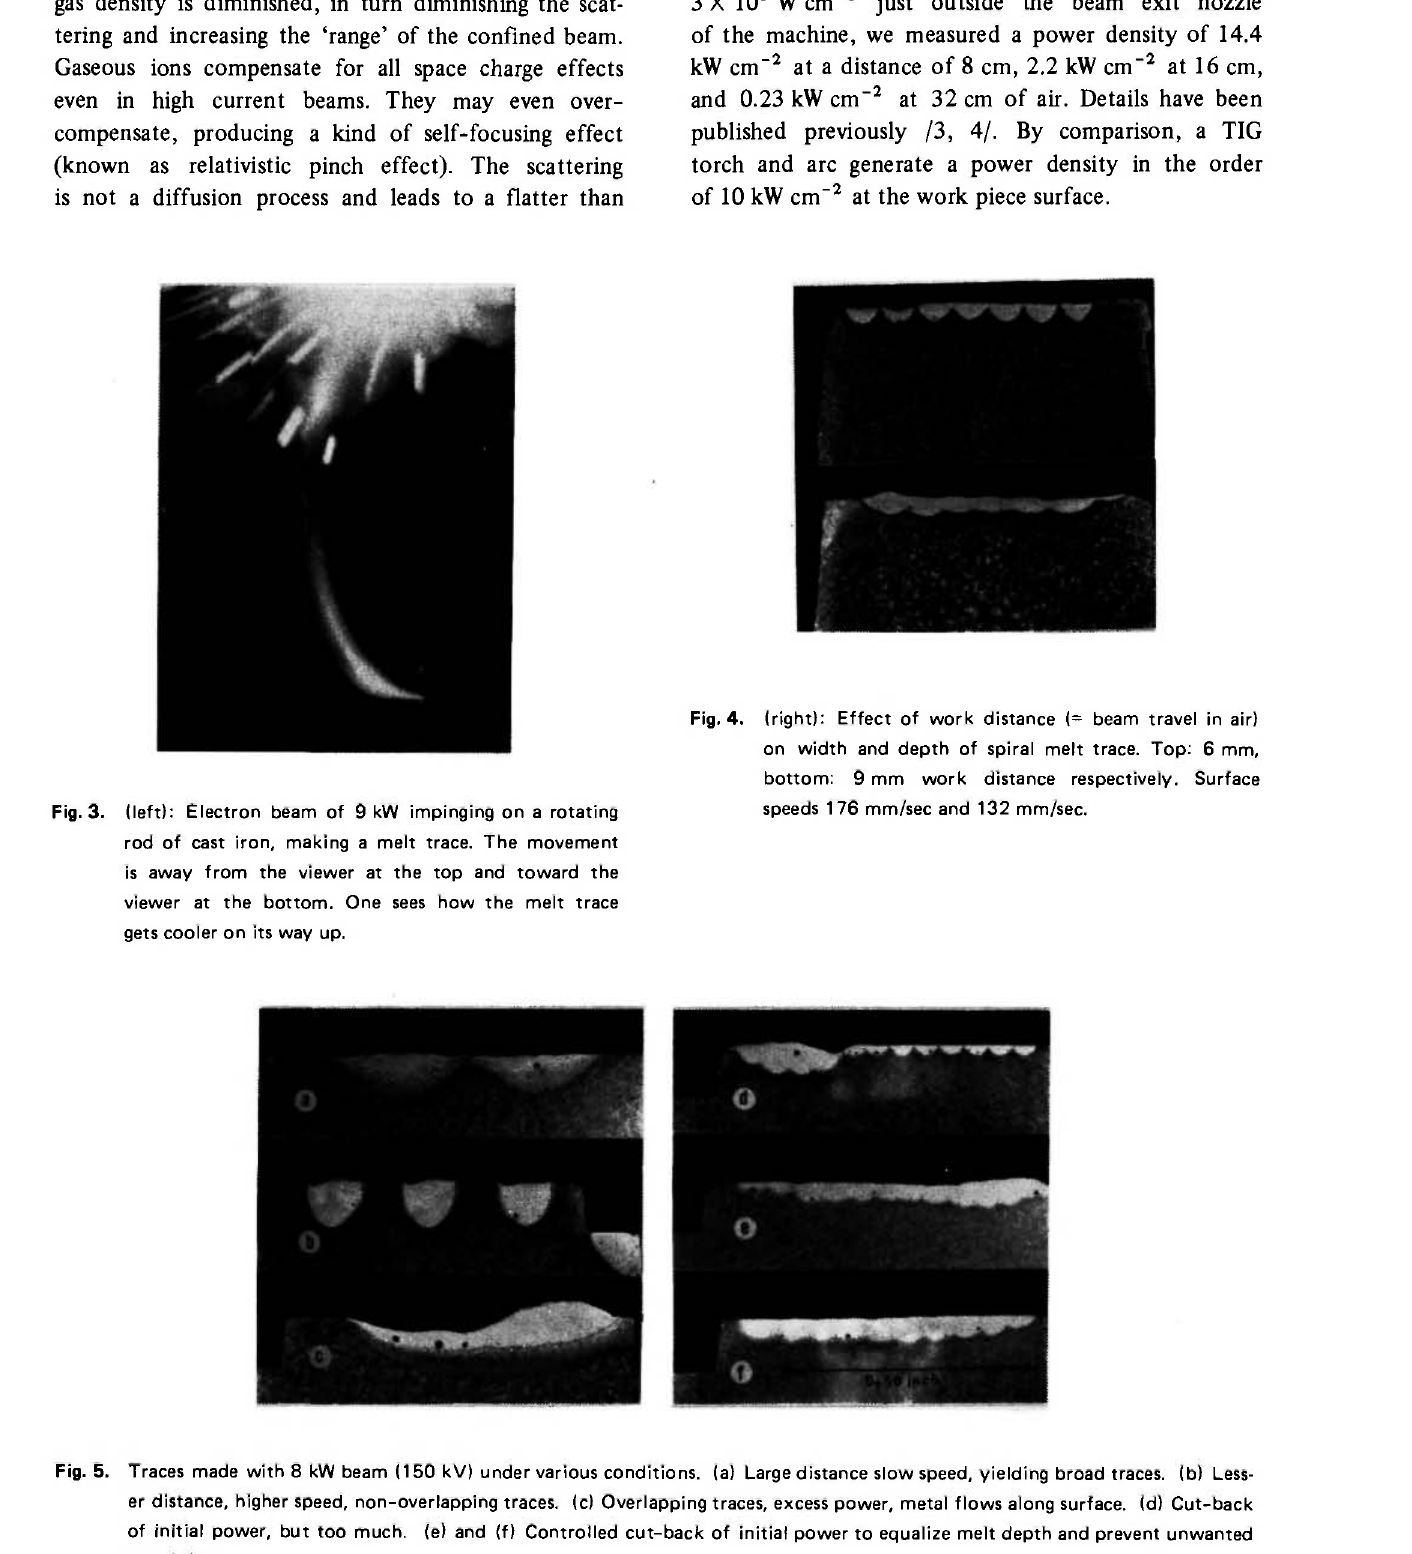
Fig. 5. Traces made with 8 kW beam (150 kV) under various conditions, (a) Large distance slow speed, yielding broad traces, (b) Less- er distance, higher speed, non-overlapping traces, (c) Overlapping traces, excess power, metal flows along surface, (d) Cut-back of initial power, but too much, (e) and (f) Controlled cut-back of initial power to equalize melt depth and prevent unwanted metal